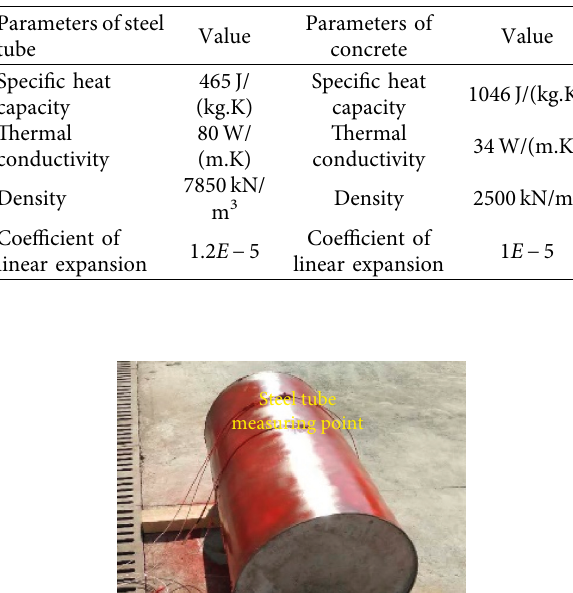
Figure 5: The network division and number of measuring points of the midspan: (a) network division and (b) number of measuring points of the midspan. Table 1: The thermal parameters of CFST materials.